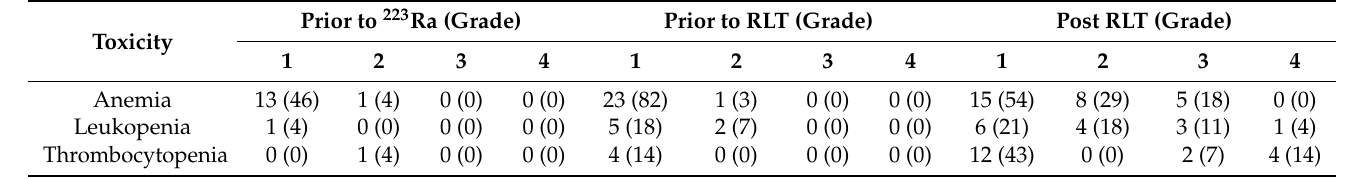
Table 3. Baseline and intra-/post-therapeutic hematologic toxicity grades based on CTCAE v5.0. Prior to 223 Ra (Grade) Prior to RLT (Grade) Post RLT (Grade) Toxicity